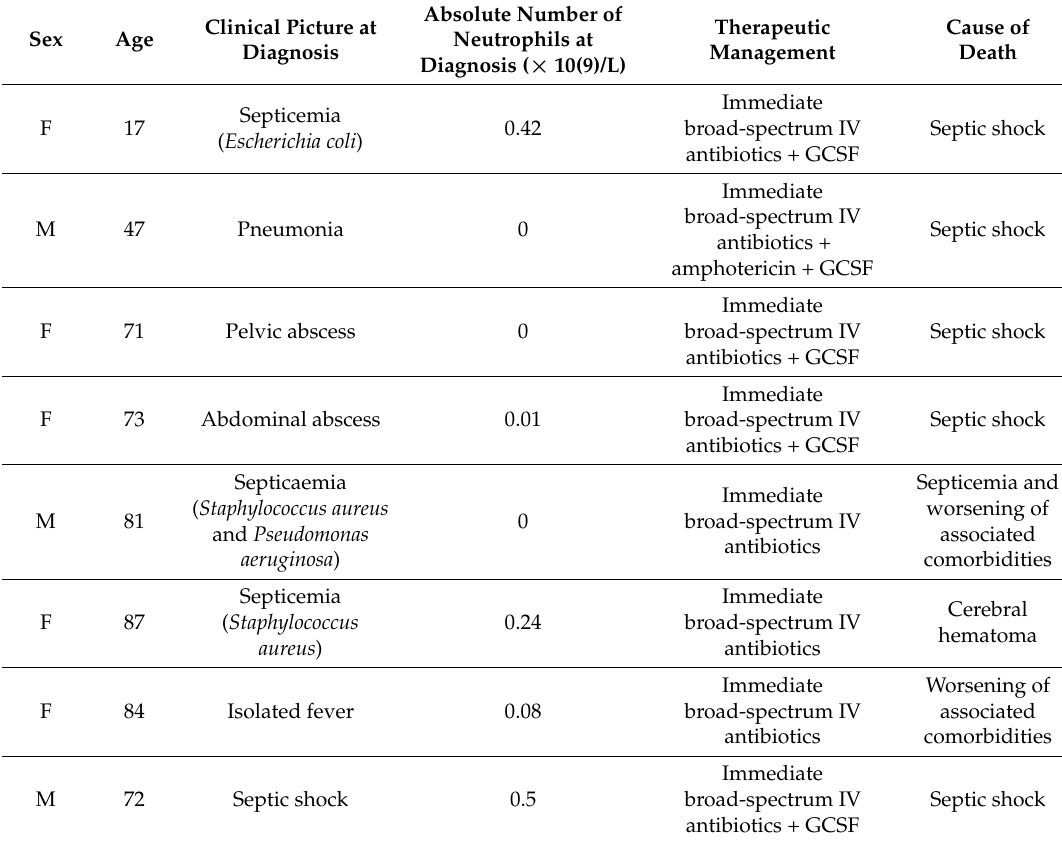
Table 5. Death causes of patients with non-chemotherapy drug-induced